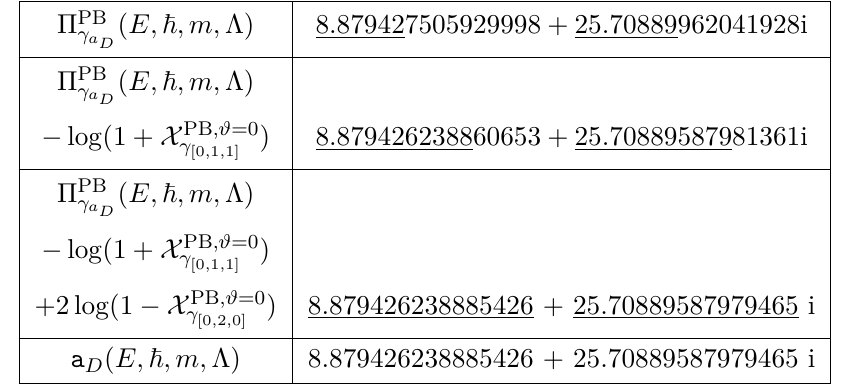
with a according to (7.13). D γ aD , ~ = 1 + i 5 10